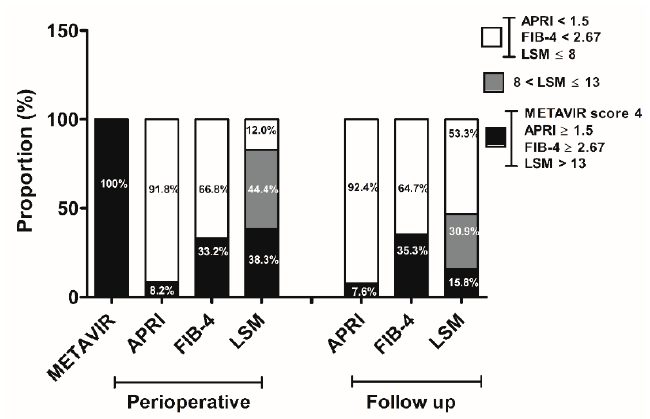
Figure 1. Changes in fibrotic burden. The proportion of patients with advanced fibrosis was assessed noninvasively by obtaining aspartate aminotransferase (AST)-platelet ratio index (APRI) and FIB-4 as well as liver stiffness (LS) values at the time of liver resection and during follow-up. METAVIR fibrosis score was evaluated from the resected liver at the time of HCC